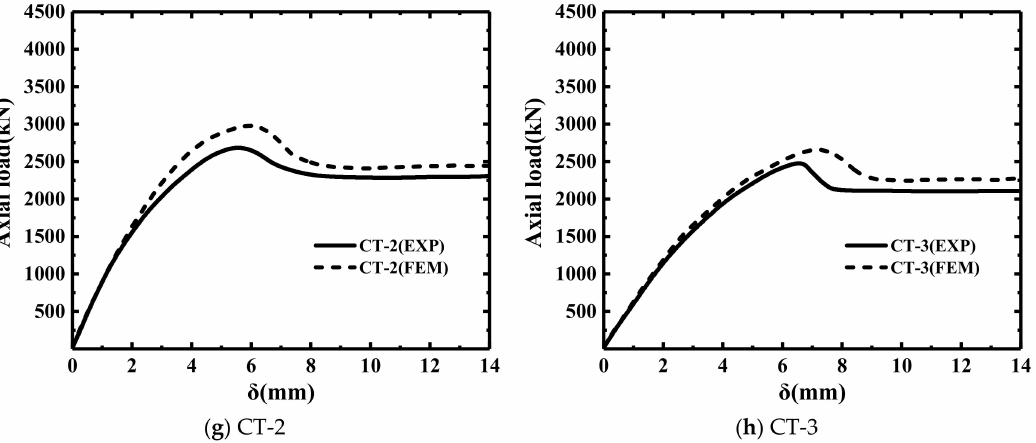
Figure 9. Comparison of the load–displacement curve between the experiments and numerical simulations.